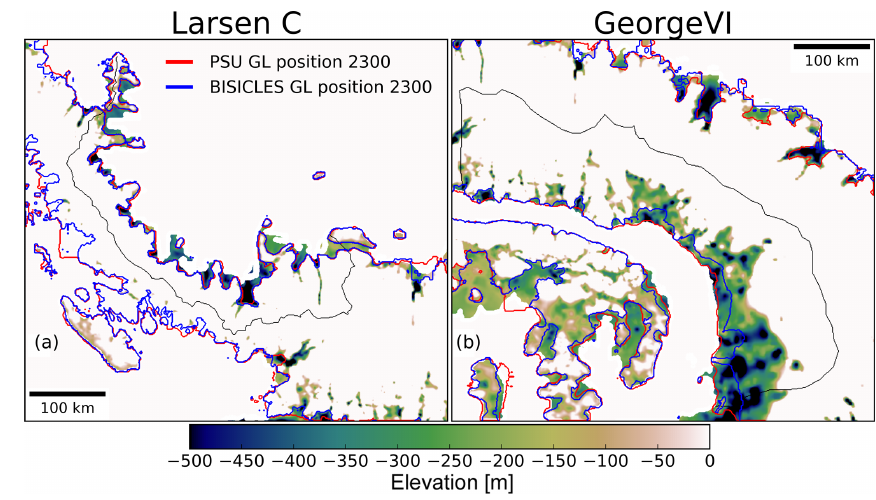
Figure A5. Comparison of modelled grounding-line positions from Experiment 2 (dynamic calving front) for the RCP8.5 scenario for Larsen C (a) and George VI embayments (b) . Black lines denote modelled drainage basins.